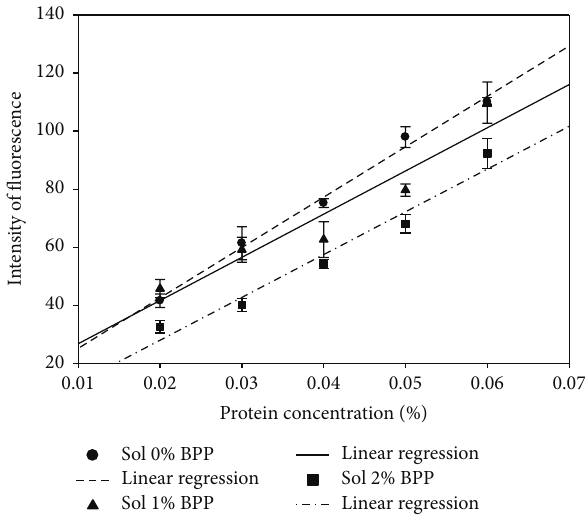
Figure 4: Effect of addition of BPP on the surface hydrophobicity of sols from giant squid ( Dosidicus gigas ). Table 1: Effect of the BPP addition on the texture parameters and water holding capacity in